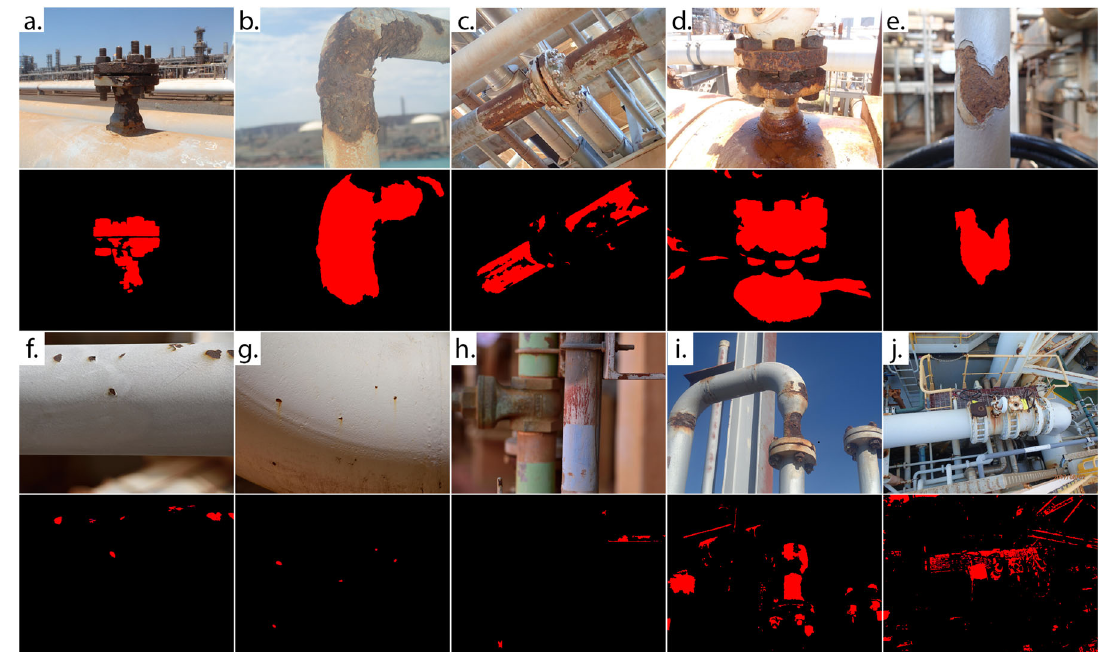
Fig. 5 Example images and ground truths from the test set. Images ( fi rst and third rows), with their corresponding ground truth label maps (second and fourth rows), red = corrosion, black = background.